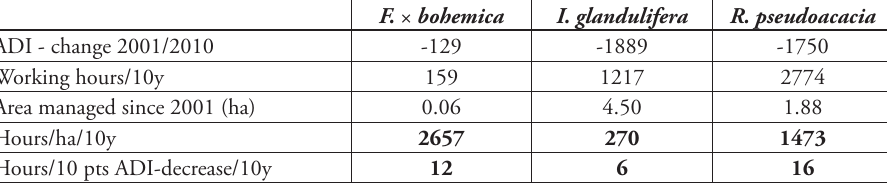
Table 2. Estimated management effort and management efficiency for Fallopia × bohemica , Impatiens glandulifera and Robinia pseudoacacia in the Austrian part of the National Park Thayatal-Podyjí. Given are the total change in ADI (=Area-Density-Index, calculated by multiplying the extent of populations (in m 2 ) by the average plant cover (in %) for each species) of managed populations between the first (2001) and second survey (2010), the total number of working hours spent for management per study species, the total extent of managed populations at the start of management (in 2001), the working hours per decade and ha, and the numbers of working hours necessary to achieve a decrease of 10 ADI-points between both surveys. Note that incomplete data on management effort for the years 2002-07 were interpolated (see main text for details).